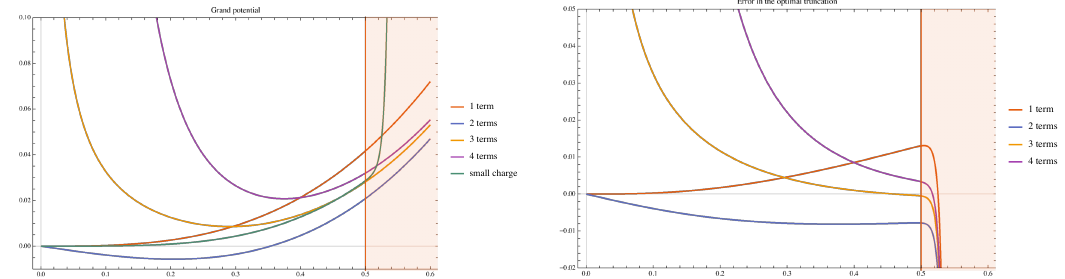
Figure 6 . Left: grand potential ω as function of m in the small charge expansion and for different numbers of terms. The small-charge expansion breaks down in the red-shaded region. Right: error in the truncation w.r.t. the exact small-charge